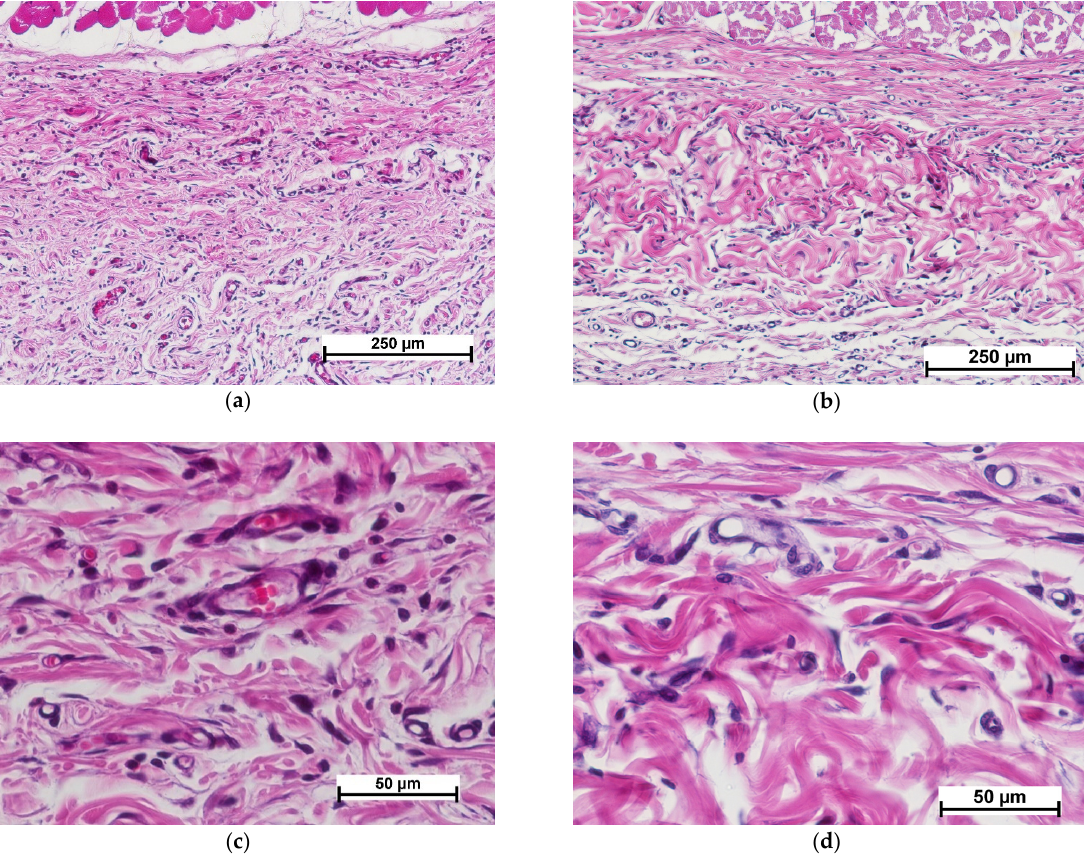
Figure 6. Histological picture—day 21. Comparison of cell-free scaffold ( a , c ) and collagen matrix ( b , d ). ( a , b )—implant site with surrounding tissue, general view, ( c , d )—connective tissue structure at the implant site. Staining with hematoxylin–eosin.